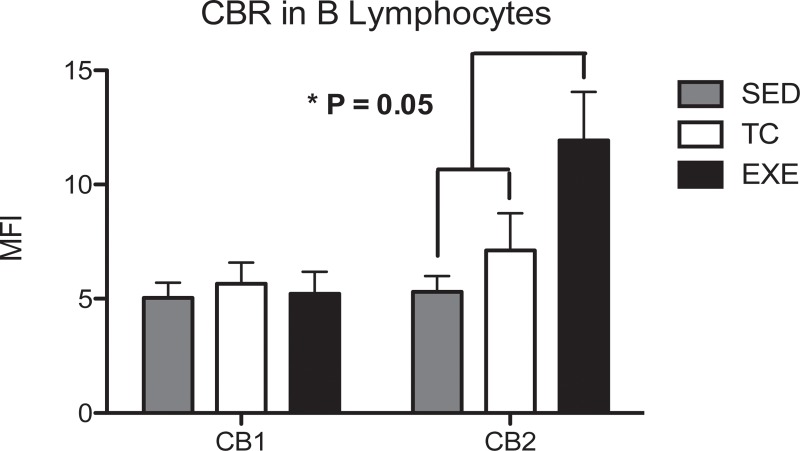
Expression of CBR in B lymphocytes from spleen.Analysis of the expression of CB1 and CB2 CBR in B lymphocytes from spleen among experimental groups: SED (shaded bar), TC (white bar) and EXE (Solid bar); data from 4 independent experiments are expressed as mean ± SE. Lines connecting bars represent comparison among groups, * p<0.05. Two way ANOVA and Bonferroni post-test, n = 10.